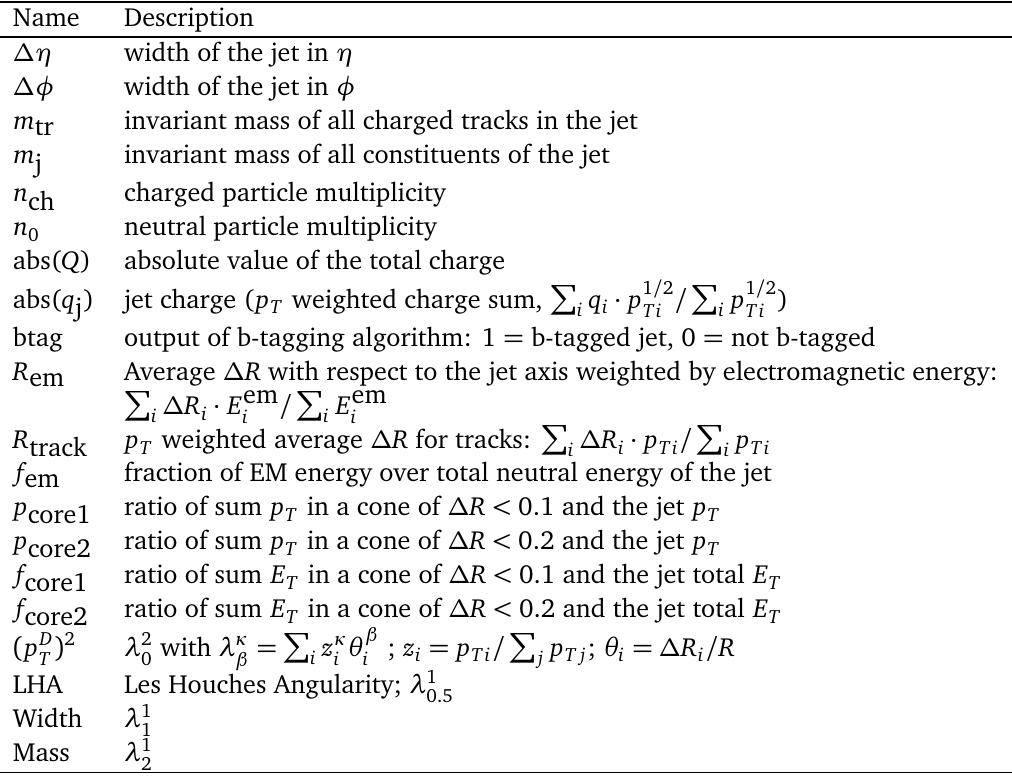
Table 1: Input variables to the charmonium